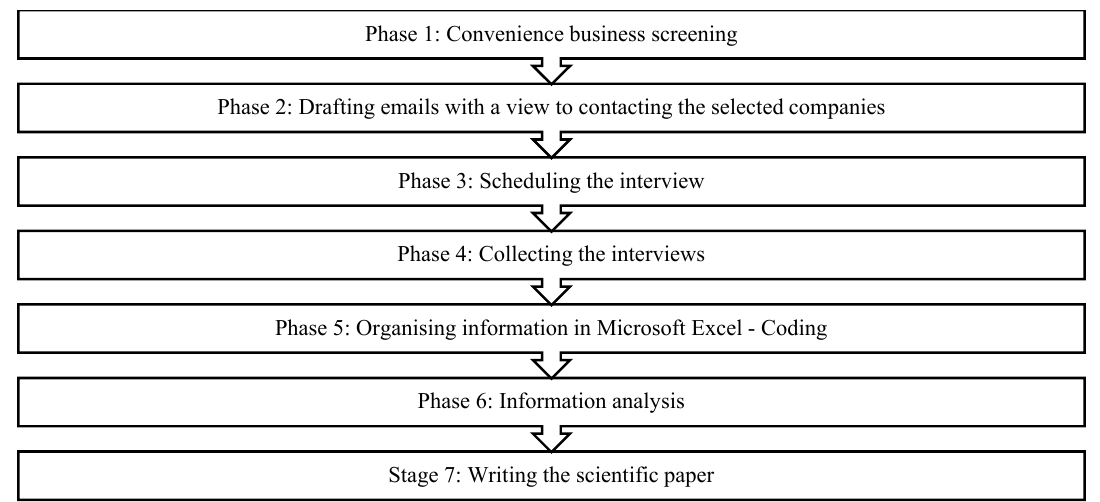
Figure 1. Process of data collection and processing.